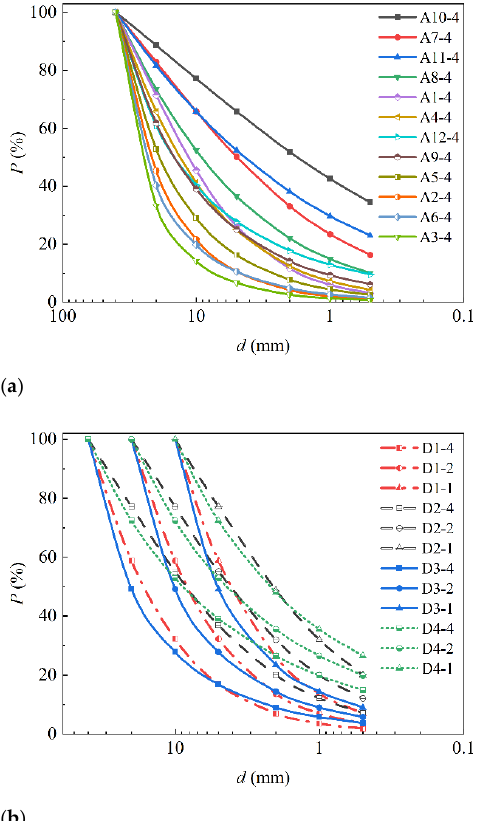
Figure 4. Gradation curves of test CGS. ( a ) Samples with same gradation structures and the different maximum particle sizes. ( b ) Samples with the different maximum particle sizes and same gradation structures.